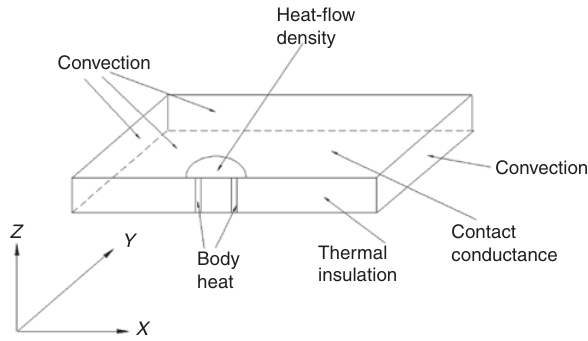
Figure 1: Boundary conditions applied on the workpiece.